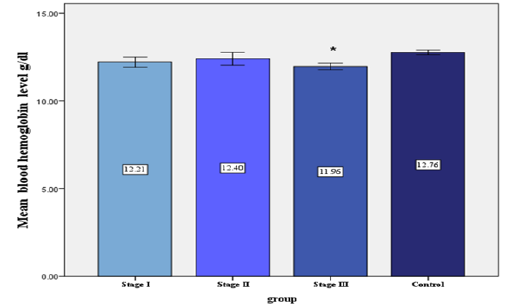
Figure 3. Mean value of blood hemoglobin among studied groups *= significantly different from control group (p˂0.05) Correlation studies were done between all studied parameters among all groups including total patients, group 1, group 2, group 3, and group 4 and the significant results (that indicated positive or negative correlation) are tabulated in table-5. Serum hepcidin levels were significantly correlated with serum FPN levels in BC patients (total patient r=- 0.407, stage II r=-0.678, stage III r=-0.433). More advanced stages of BC (stage III) were presented with more significant correlation between FPN levels and blood platelet count (r=-0.438).